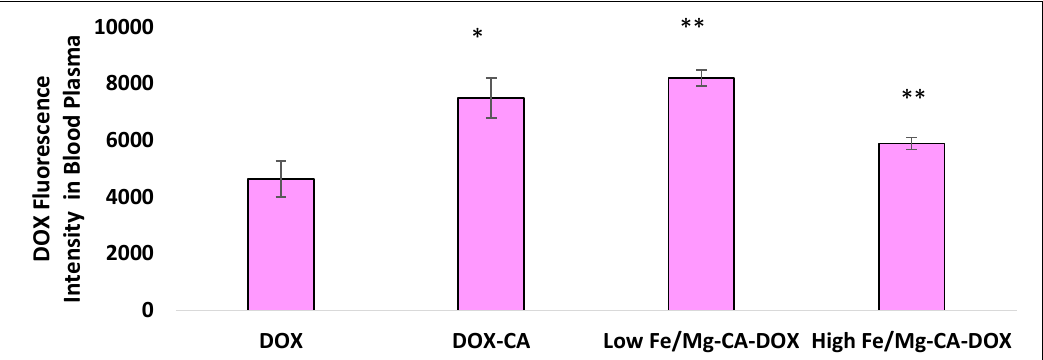
Figure 18. DOX fluorescence intensity in the blood plasma of Balb/c 4T1 tumor-bearing mice after 24 h of intravenous injection with DOX solution, DOX-CA NPs, low DOX-Fe/Mg-CA NPs and high DOX-Fe/Mg-CA NPs for DOX solution. Results were considered significant at p-value 0.01–0.05 (*), very significant at p-value 0.001–0.01 (**), highly significant at p-value 0.0001–0.001 (***) and extremely significant at p-value ˂ 0.0001 (****). P values were calculated with respect to control (DOX in media) and treatment (DOX bound NPs). The confidence interval was 95% for the respective